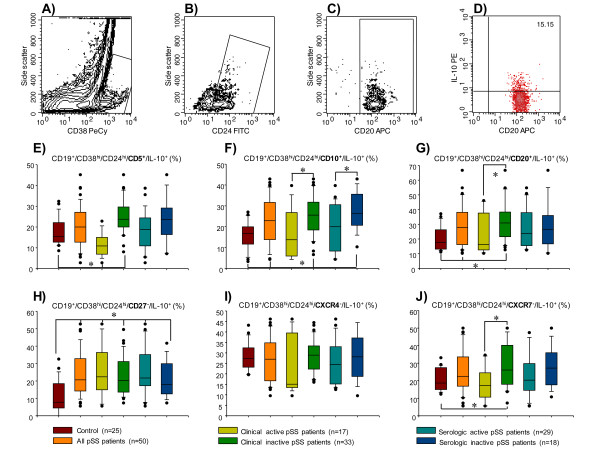
Percentage of immature/transitional IL-10-producing B peripheral-cell subtype in patients with primary Sjögren's syndrome (pSS). CD19+ blood B cells were obtained by positive selection with microbeads. (A) Representative contour plot of CD19+ B cells. An electronic gate was made for CD38hi cells. (B) From the gate A CD19+⁄CD38hi⁄CD24hi cells were determined. (C) From the gate B CD19+⁄CD38hi⁄CD24hi⁄CD20+ were defined. (D) From the latter CD19+⁄CD38hi⁄CD24hi⁄CD20+⁄IL-10+ cells were determined. Bar graphs show percentage of (E) CD19+⁄CD38hi⁄CD24hi⁄CD5+⁄IL-10+, (F) CD19+⁄CD38hi⁄CD24hi⁄CD10+⁄IL-10+, (G) CD19+⁄CD38hi⁄CD24hi⁄CD20+⁄IL-10+, (H) CD19+⁄CD38hi⁄CD24hi⁄CD27-⁄IL-10+, (I) CD19+⁄CD38hi⁄CD24hi⁄CXCR4+⁄IL-10+-, and (J) CD19+⁄CD38hi⁄CD24hi⁄CXCR7+⁄IL-10+-producing B peripheral cells. A total of 50,000 to 100,000 events were recorded for each sample before any gate setting and were analyzed with the CellQuestPro software (BD Biosciences). (E-J) Results are expressed as median, 10th, 25th, 75th, and 90th percentiles. *P < 0.05.